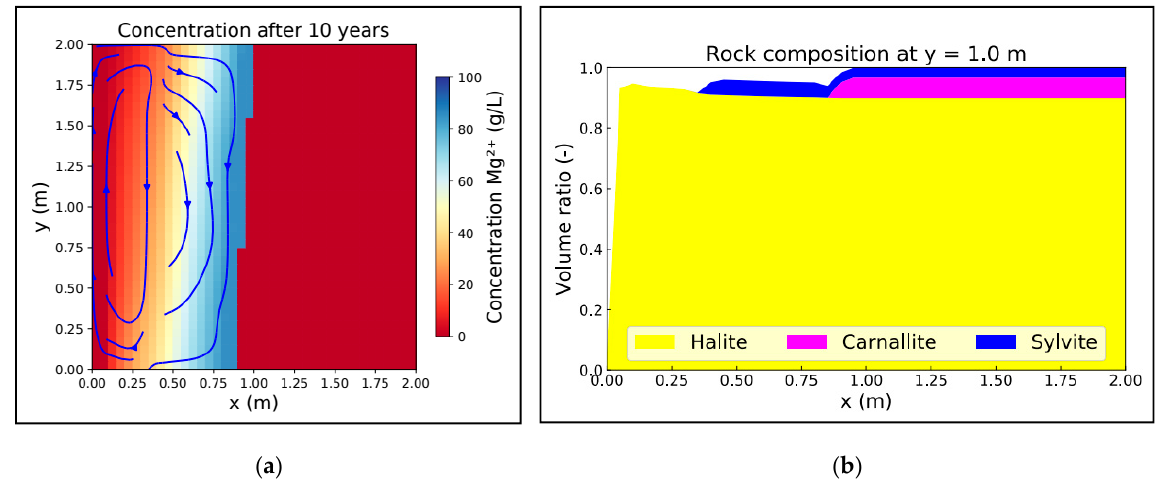
Figure 10. ( a ) Mg 2+ concentration distribution and ( b ) mineralogy for a transport- and diffusion-dominated system (scenario: dissolution rate 10 − 5 cm/s and 5 wt.% carnallite).